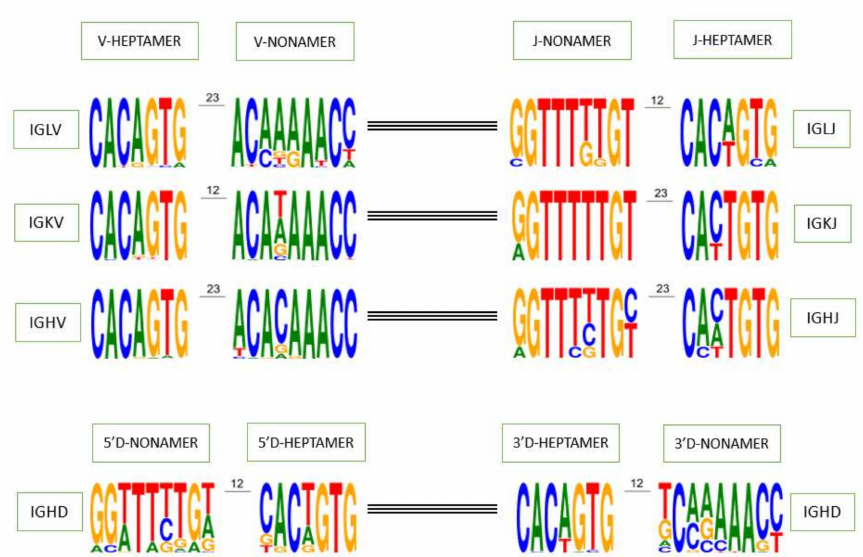
Figure 3. Recombination signal sequences of functional V, D and J genes (V-RS, 5 (cid:48) D-RS, 3 (cid:48) D-RS and J-RS respectively) for each IG locus of the rhesus monkey. The height of symbols indicates the relative frequency of each nucleotide at that position. Data extracted from IMGT Repertoire (IG and TR) http://www.imgt.org/genedb/, accessed on 11 November 2021 and depicted as sequence logos by WebLogo